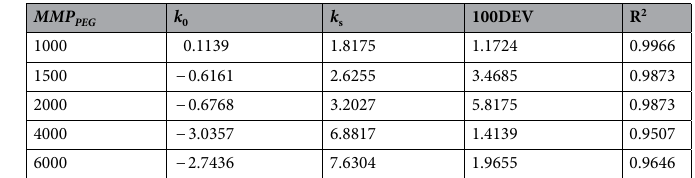
Table 5. Results of the fitting of the experimental tie-line compositions with the Seteschenow-type model (i.e., Eq. 14) for PEG 1000,1500,2000,4000,6000 (1) + trilithium citrate (2) + water (3) system at T = 298.15 K. R 2 is the coefficient of determination for linear relation of ln − w cal 6 N , where w w exp p , l , j p , l , j p,l,j is the mass fraction of component j (i.e. polymer, salt, or water) for l th tie-line composition in the phase p , and N is the number of experimental ( exp ) or calculated( cal ) (cid:29)(cid:28) tie-line compositions.